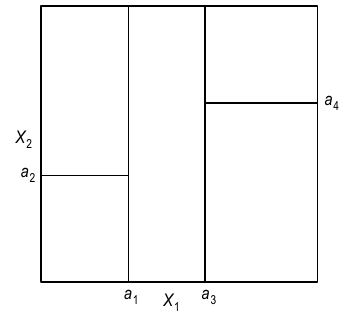
Fig. 2. Time series of arrivals at the TCT of Cagliary